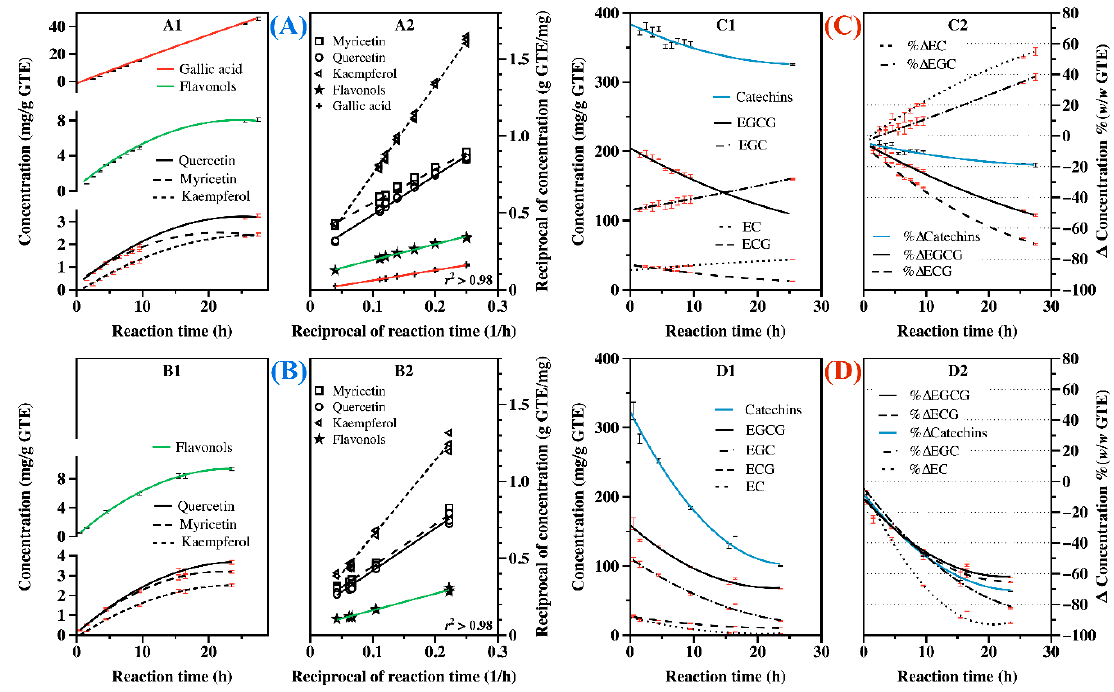
Figure 6. Reaction trends of CF enzyme-based ( A , C ) and hydrochloride-based ( B , D ) hydrolysis of GTE. The components of GTE were measured (n = 3) by time-course reactions. A2 and B2 were fitted by a first-order regression, while the others were fitted by a second-order regression from an equation of SigmaPlot 10 (Systat Software, Inc., San Jose, CA, USA).